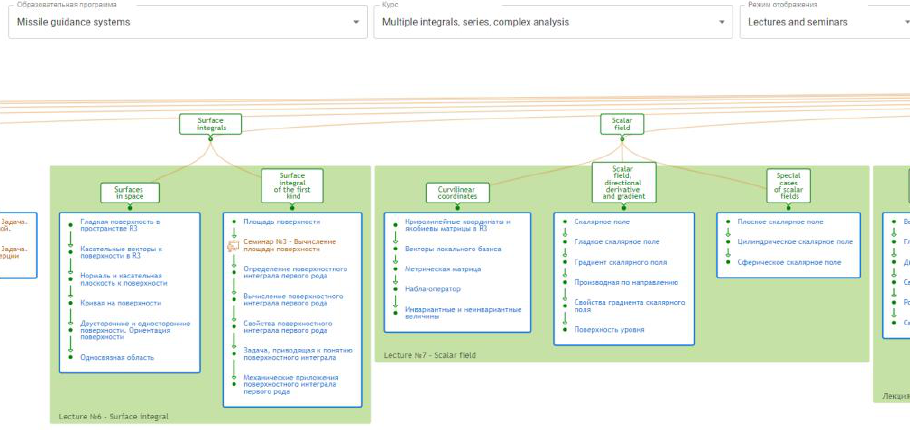
Fig. 5. The course "Multiple Integrals, Series, Complex Analysis".